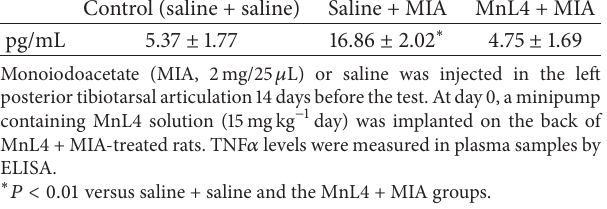
Table 2: TNF 𝛼 plasma levels in control, MIA- and MnL4 + MIA- treated rats. Control (saline + saline) Saline + MIA MnL4 + MIA pg/mL 5.37 ± 1.77 16.86 ± 2.02 ∗ 4.75 ±